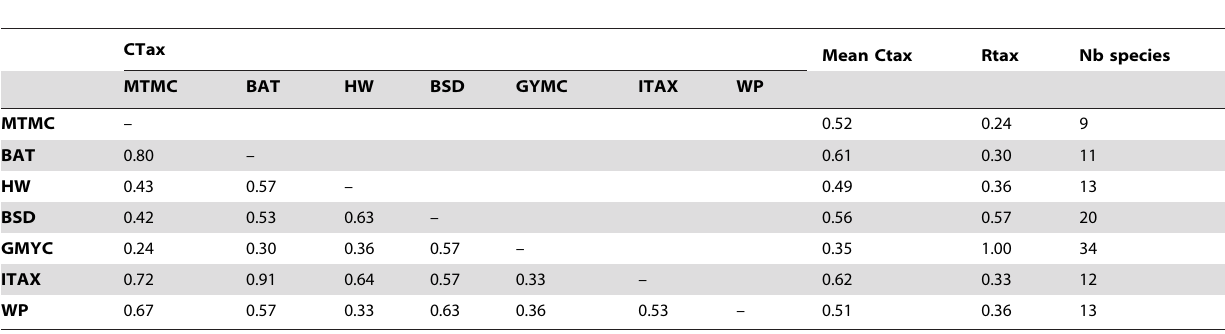
Table 2. Summary of descriptive statistics employed to assess absolute and relative performance of the approach used for species